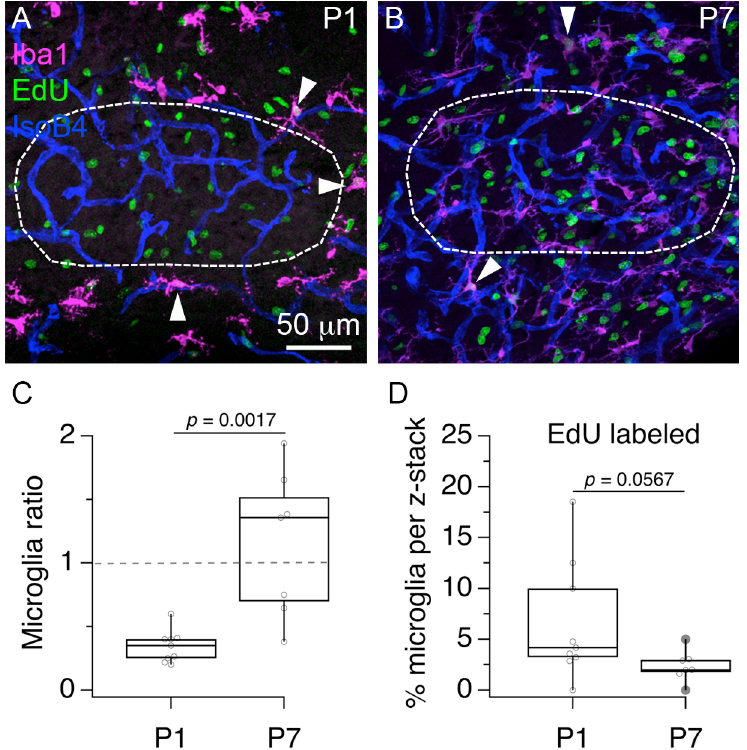
Figure 5. Visualization of proliferating microglia in the MNTB vascular niche. ( A ) Exemplar 3D rendering of triple labeled brainstem section at P1 shows the MNTB outline (white dashed line) and the localization of anti-Iba1 labeled cells (magenta), Edu-labeled cells (green) and IsoB4-labeled blood vessels (blue). ( B ) Exemplar 3D rendering of triple labeled tissue at P7. White arrowheads in A and B indicate anti-Iba1 and EdU double labeled cells. ( C ) Microglia ratio at P1 and P7. ( D ), Percent of anti-Iba1 labeled cells that co-labeled with EdU at P1 and P7.